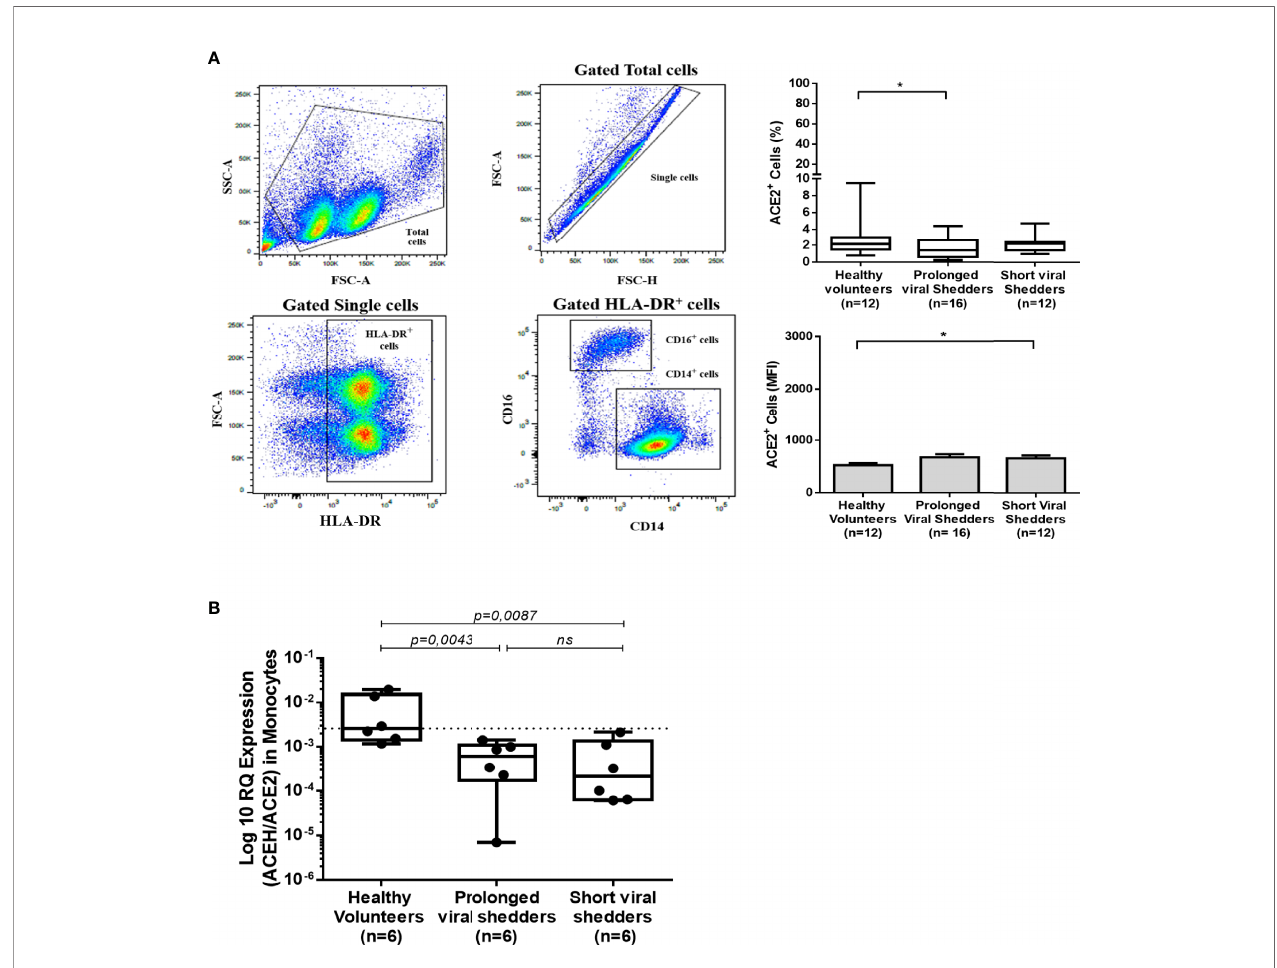
FIGURE 2 | ACE2 expression in HLA-DR + /CD14 + monocytes from COVID-19 patients and healthy volunteers. (A) Flow cytometry analysis of ACE2 protein expression at the surface of different cell populations during COVID-19. The fi gure illustrates the results obtained with the HLA-DR + /CD14 + population while data obtained with respect to other cell populations are presented in the Supplementary Figure S1 . The gating (left panels) was performed using different cluster differentiation-speci fi c mAb (CD14, HLA-DR). The right panels show the percent of monocytes expressing ACE2 (upper right panel) and their ACE2 mean fl uorescence intensity (lower right panel). (B) Analysis of ACE2 mRNA expression in monocytic cells (simply selected by adherence to tissue culture plates) using qRT-PCR. Monocytic cells from prolonged viral shedders (n = 6), short viral shedders (n = 6), and healthy donors (n = 6), were tested for ACE2 mRNA expression. The data are expressed as log10 RQ were RQ = 2 ( − D CT) . Mann – Whitney test was used for the statistical analysis of all data. *p value < 0.05; ns, not signi fi